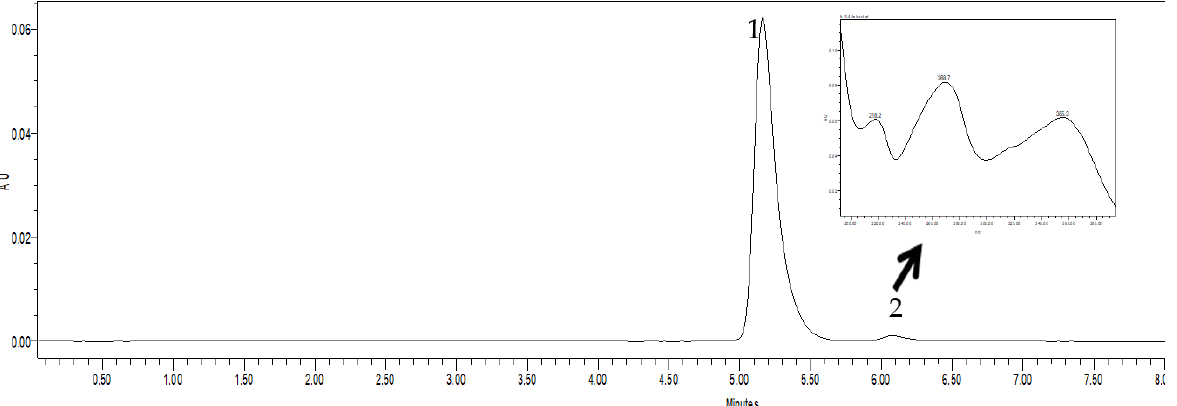
Figure 4. Chromatogram of a standard solution of oxytetracycline hydrochloride. * Note: in this and